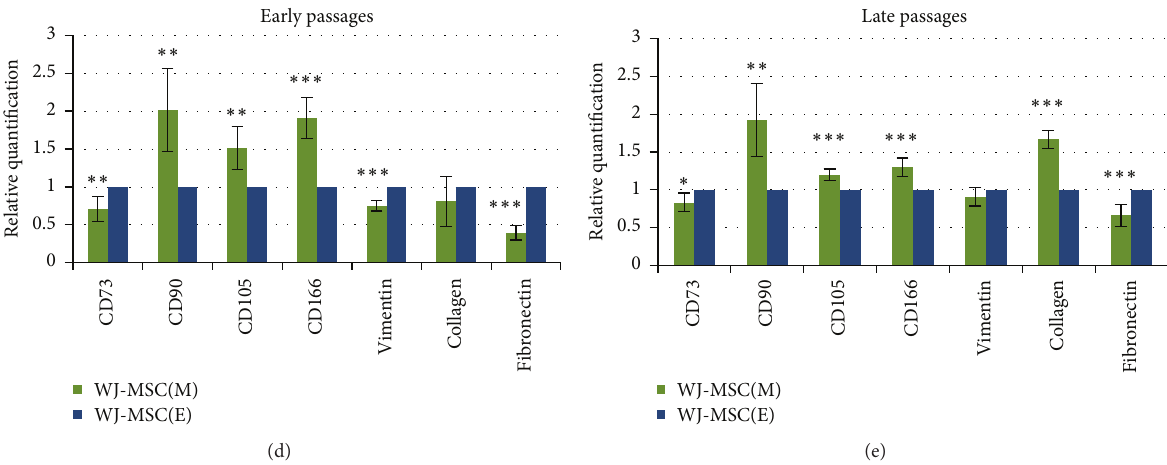
Figure 1: (a) Isolation efficiency. Average number of cells isolated by enzymatic method WJ-MSC(E) is initially higher than cells obtained by mechanical method WJ-MSC(M). Furthermore, under 5% O 2 , the number of received cells significantly increases in all variants of isolation. The results are presented as mean values of 3 isolations ± SD, ∗∗∗ 𝑝 < 0.001 . (b) Flow cytometry analysis. Flow cytometry analysis showed in both types of cultures almost identical typical and relatively high expression of specific mesenchymal markers (CD73, CD90, and CD105). Similarly, not more than 1% of WJ-MSC(E) express negative markers (CD34, CD11b, CD19, CD45, and HLA-DR). (c) Immunocytochemical analysis of WJ-MSC(M) and WJ-MSC(E). Expression of the classical mesenchymal markers revealed presence of the discrete but detectable differences for both types of culture at early passages. (d, e) Quantitative analysis of mesenchymal marker genes expression in early/late passages. Relative expression of WJ-MSC(M) at early (2nd-3rd) and late (8th) passages normalized to the reference gene ACTB was compared to WJ-MSC(E) as calibrator group. The results are presented as mean values of 3 isolations ± SD; ∗ 𝑝 < 0.05 ; ∗∗ 𝑝 < 0.01 ; ∗∗∗ 𝑝 < 0.001